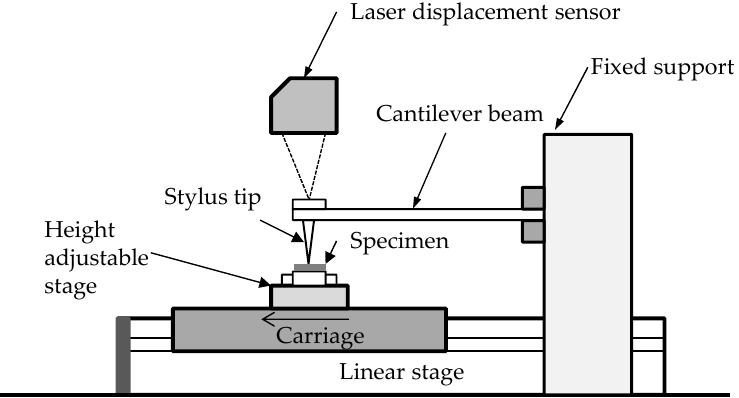
Figure 1. In-house developed cantilever beam–type tester using a mechanical metallic stylus